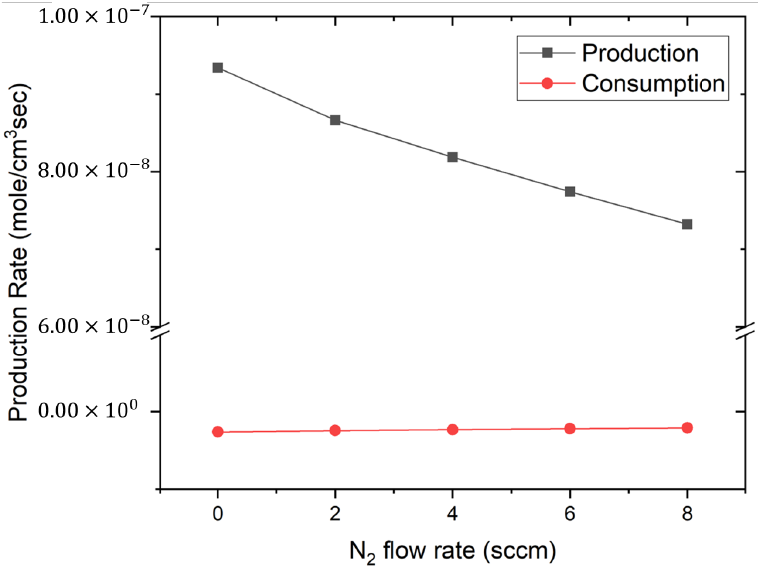
Figure 9. Production rate of the F atoms based on the N 2 flow rate. The consumption rate, shown in the red line, has a negative value since it uses the generated F atoms.